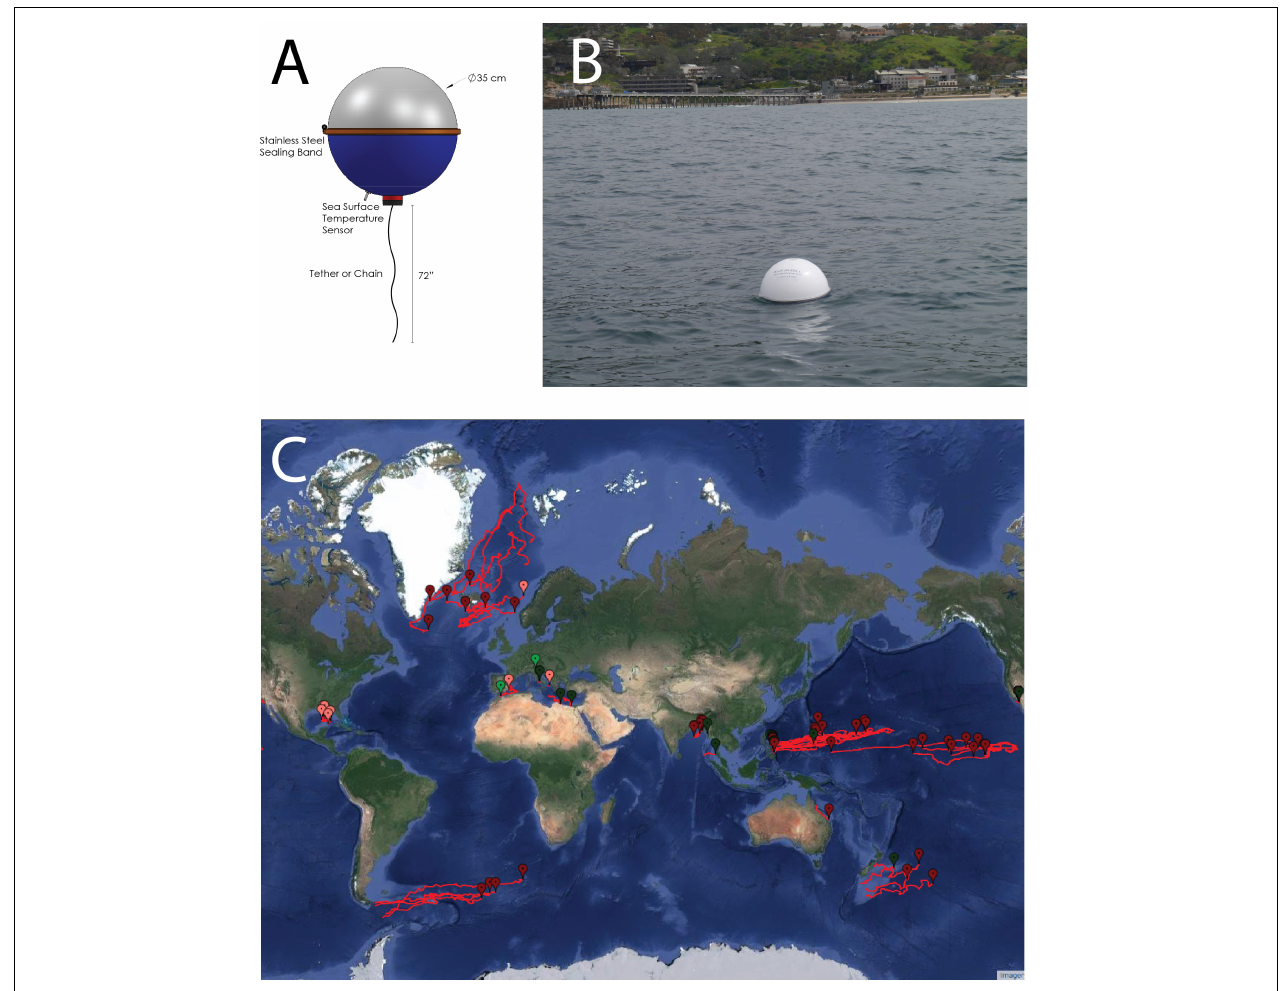
FIGURE 7 | Schematic of the DWS drifter (A) . A LDL DWS drifter test deployment off the SIO pier (B) . Tracks of the 69 DWS drifters deployed to date by the LDL (C) .